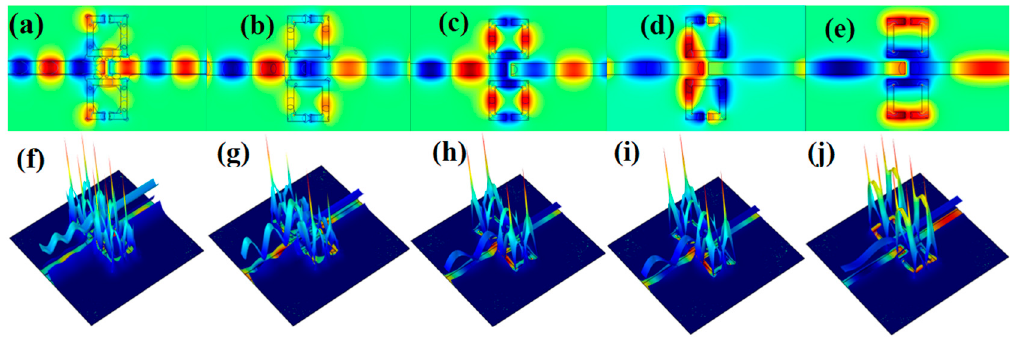
Figure 3. ( a – j ) The 2D and 3D distributions of magnetic field intensity ( |Hz| 2 ) at λ = 542 nm, 650 nm, 698 nm, 968 nm and 1313 nm.